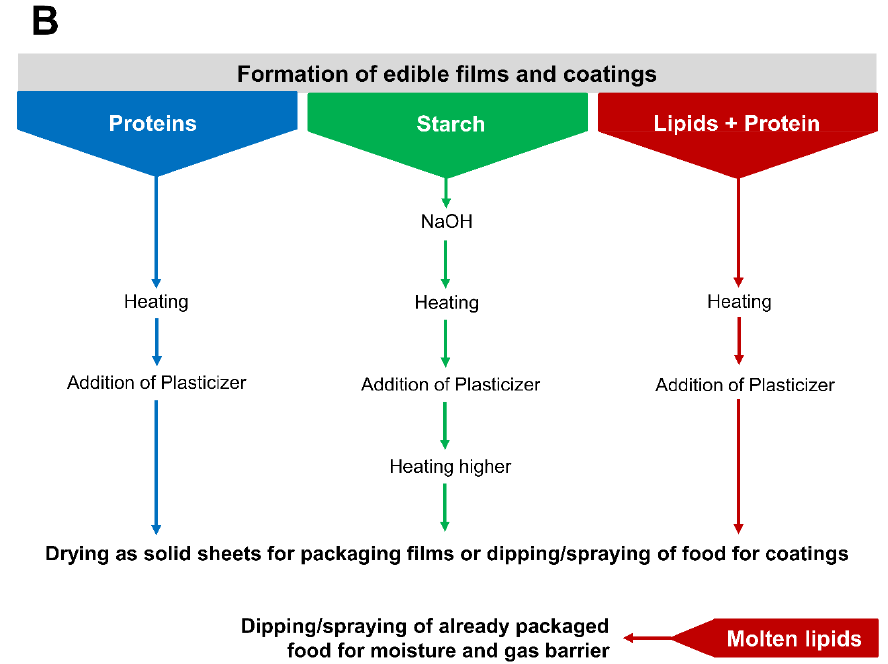
Figure 1. Use of food wastes and by-products for food packaging. ( A ) Food waste resources for edible films and coatings and their preferred application in food packaging (modified and extended according to Janjarusskul et al. [81], Rawdkuen et al. [87], and Huber et al. [88]). ( B ) Formation of edible films and coatings based on the recycling of starch, proteins, and/or lipids.